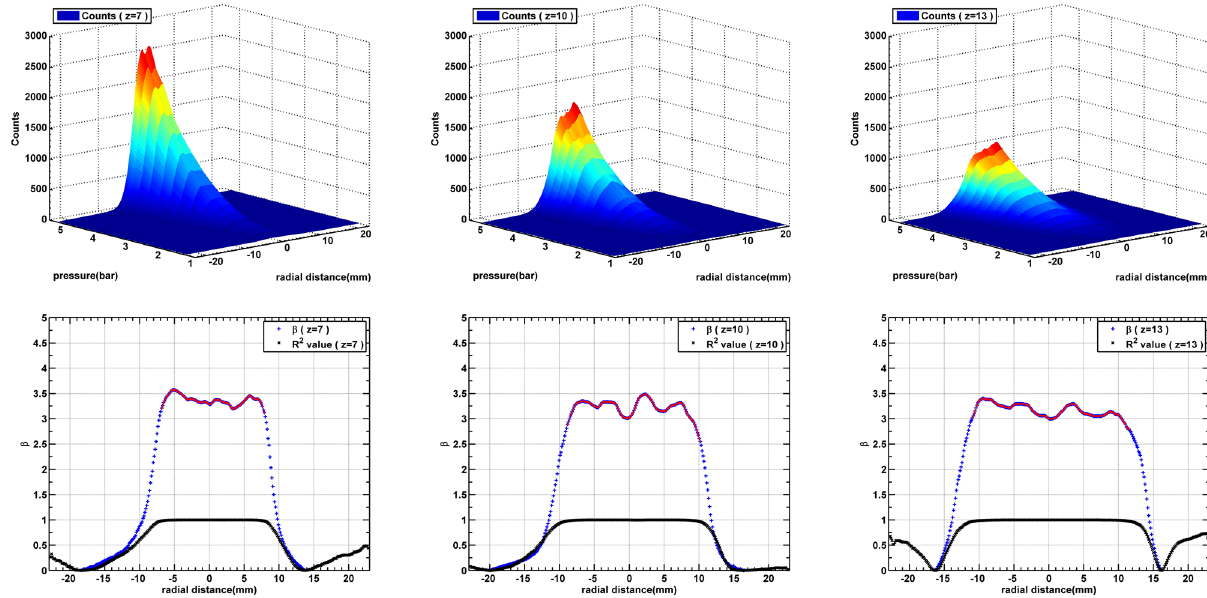
Figure 4. Pressure vs intensity curves at three different distances from the nozzle. It can been seen that at all the three distances co-efficient of power law fit along the radial direction is approximately 3.25 only those values of β (masked in red) whose goodness of power law fit (denoted by R 2 ) is greater than 0.95 are